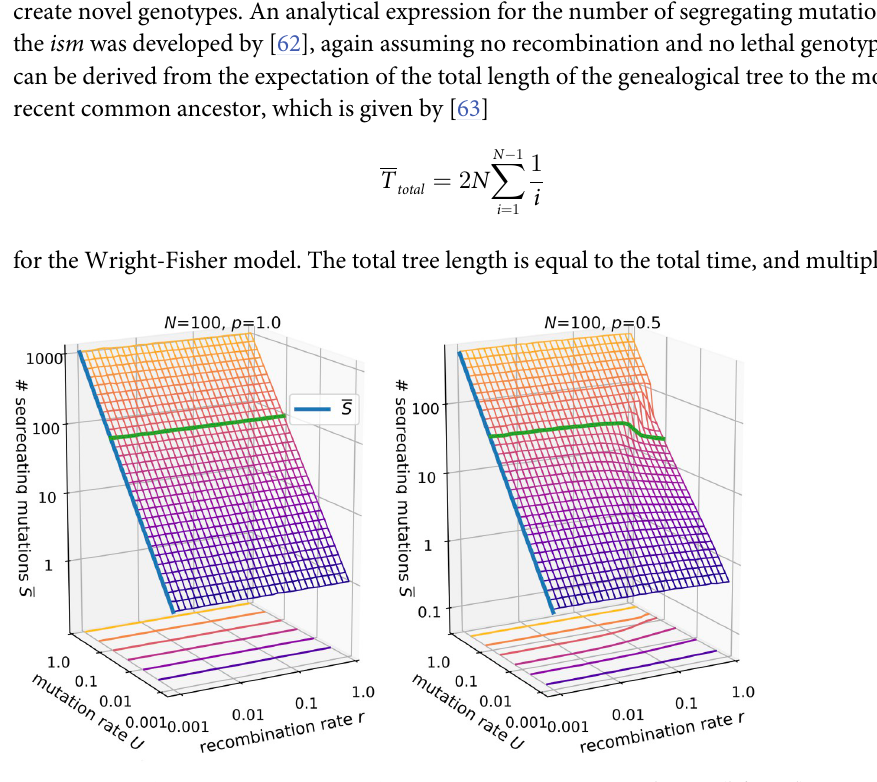
Fig 5. Number of segregating mutations in the ism . Parameters are N = 100 and p = 1.0 (left panel) vs. p = 0.5 (right panel). The blue lines shows Eq 16. The green line is drawn at U = 0.1.